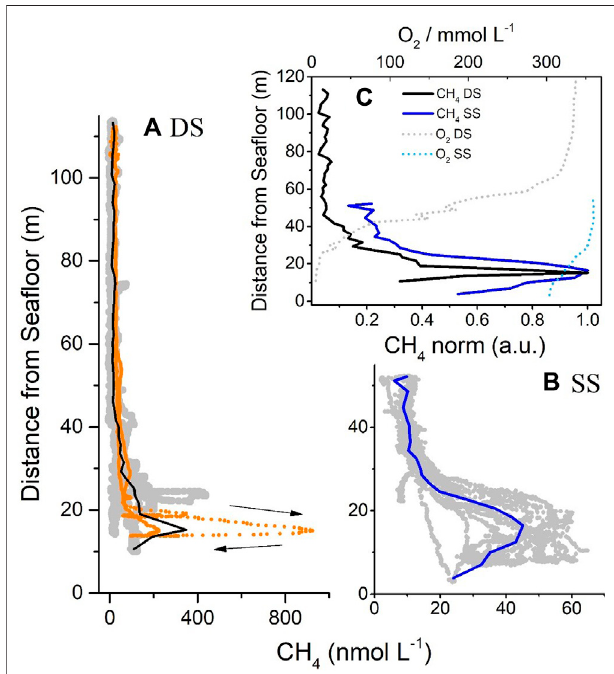
FIGURE 7 | (A) A compilation of vertical pro fi les acquired with the MILS probeatthedeeperlocation(VP01,02,03and04foratotaloffourdown-andup- casts)and (B) attheshallowerlocation(VP05whichisaseriesofsevendown-and up-casts) (grey dots). The pro fi le VP04 is represented with orange dots, highlighting the temporal evolution of the measurement during the descent and ascent(blackarrows).Blackandbluelinesare2-maveragevalues. (C) theaverage curvesofdissolvedCH 4 (solid lines), normalized by themaximumconcentrationat eachsite,areplottedagainstthedistancefromthesea fl oor,showingasimilar and expected exponential dissolution trend. While at the DS dissolved CH 4 concentrations reached background value at 50 m from the sea fl oor, at the SS, methane concentration at the sea surface was ∼ 20% of the maximum of the average concentration measured at the sea bottom. The average variations in dissolved O 2 at both locations are also reported (dotted